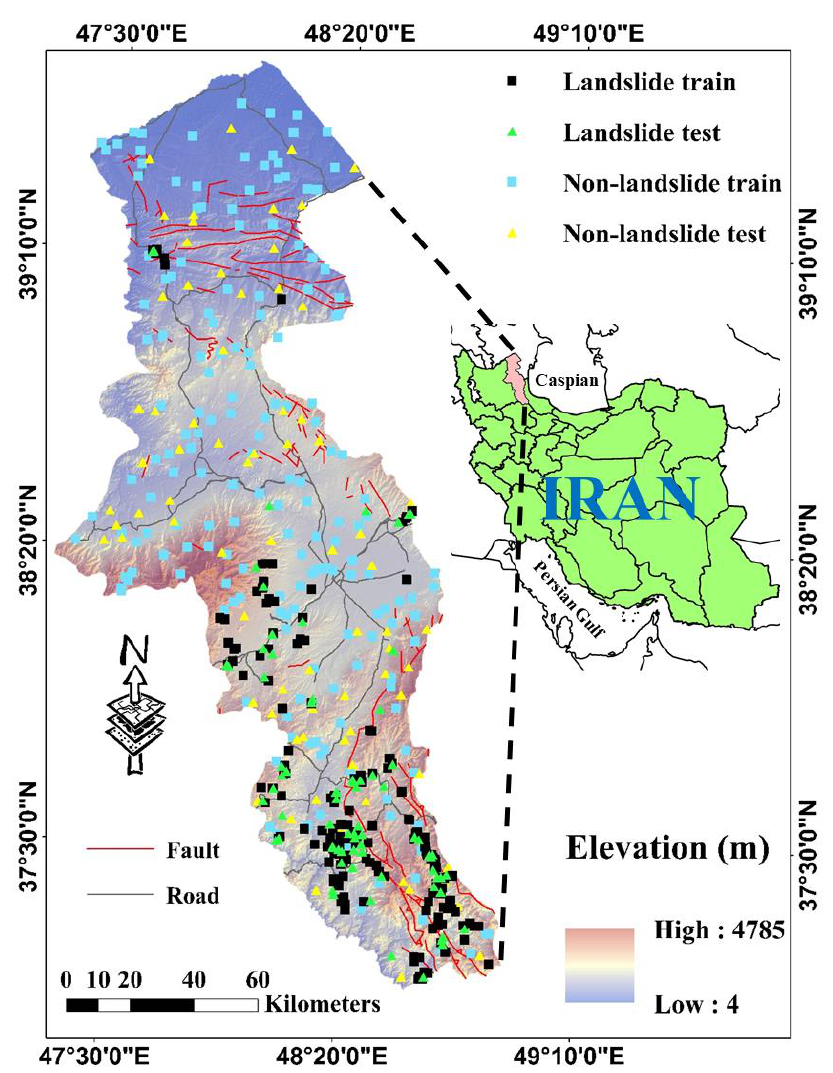
Figure 1. Location of the study area and spatial distribution of the landslides.